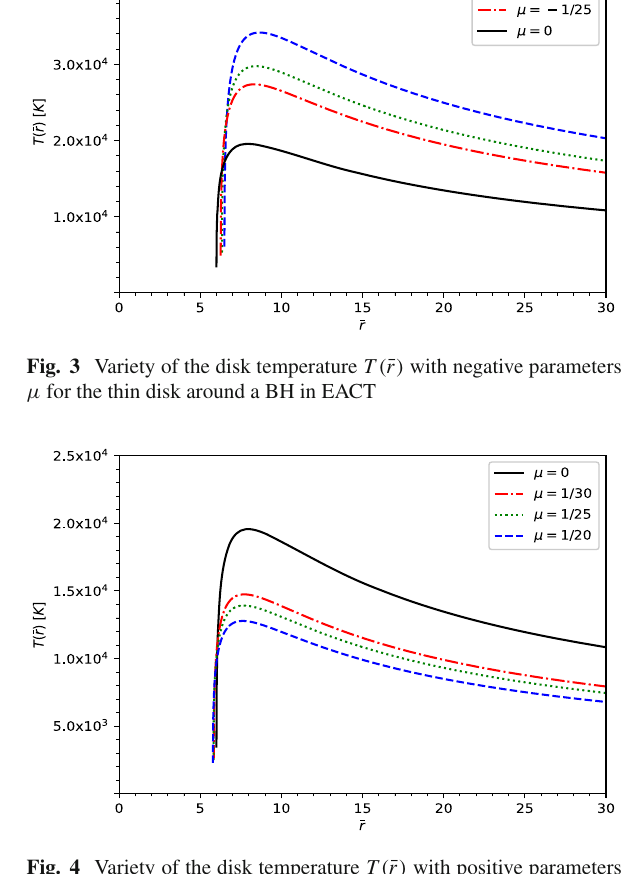
Fig. 4 Variety of the disk temperature T ( ¯ r ) with positive parameters μ for the thin disk around a BH in EACT